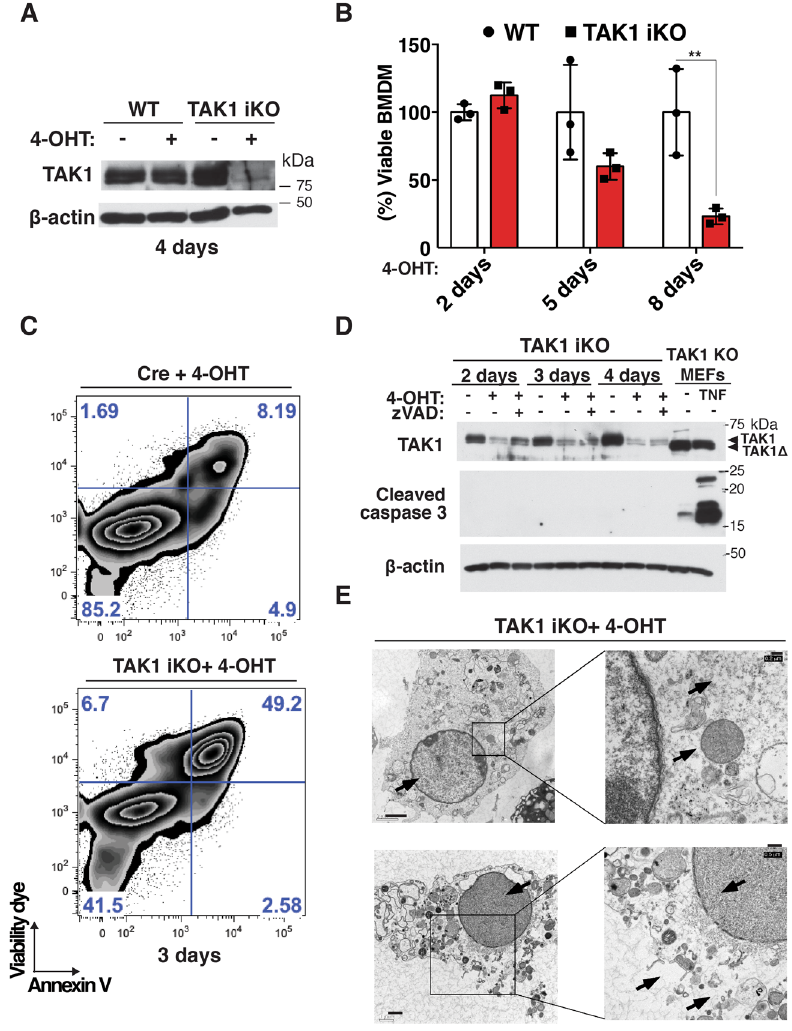
Figure 1. TAK1 deletion induces macrophage cell death with necrotic features ( A ) WT and TAK1 iKO BMDMs were treated with 0.3 µ M 4-OHT or vehicle (ethanol) for 4 days. Expression of TAK1 was analyzed by immunoblotting. ( B ) WT and TAK1 iKO BMDMs were treated with 0.3 µ M 4-OHT or vehicle for indicated days. Cell viability was measured by crystal violet assay. Data are the result of 3 independent experiments and show mean percentages of TAK1 iKO cell viability in each day + / − SD. ** p-value < 0.01; two-way ANOVA ( C ) Cre-alone and TAK1 iKO BMDMs were treated with 0.3 μ M 4-OHT for 3 days. Floating and attached cells were collected and stained with annexin V-Pacific Blue and Fixable viability dye eFlour 780, then analyzed on flow cytometer. The results shown are representative of 3 independent experiments. ( D ) WT and TAK1 iKO BMDMs were treated with 0.3 µ M 4-OHT or vehicle (ethanol) together with or without 20 µ M zVAD for indicated days. Caspase 3 activation was analyzed by anti-cleaved caspase 3 immunoblotting. Tak1-deficient fibroblasts (TAK1 KO) treated with 20 ng/ml TNF for 6 h was used as positive control for caspase 3 activation. ( E ) TAK1 iKO BMDMs at 5 days post 4-OHT treatment were analyzed using a transmission electron microscope. Scale bars, 2 μ m (top left), 0.2 μ m (top right), 1 μ m (bottom left) or 0.5 μ m (bottom right) as shown. Top images: Arrows indicate swollen mitochondria and enlarged nucleus and cytoplasm. Bottom images: Arrows show disrupted plasma membrane and perforated nuclear envelope and lack of nuclear